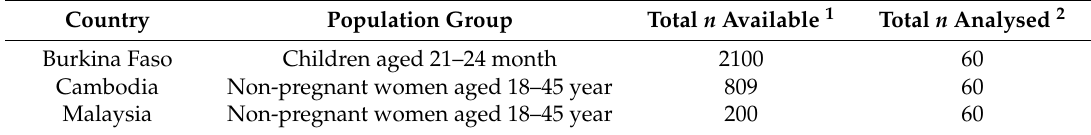
Table 1. Summary of the origin of the 180 serum samples included for method-comparison